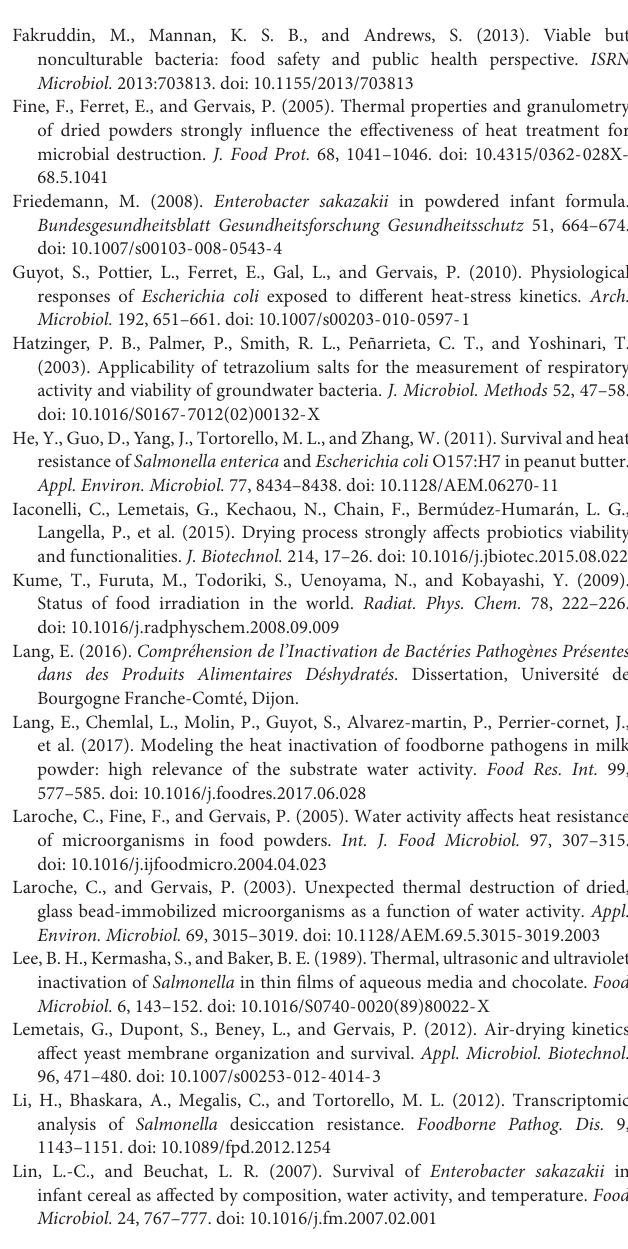
FIGURE S1 | Gating strategy for flow cytometry analysis. ( ∗ ) In the case of PI, the labeled cells were permeabilized cells. In the case of CTC, the labeled cells were the respiring cells. TABLE S1 | Logarithmic inactivation corresponding to unculturable percentage for each bacterium and each treatment